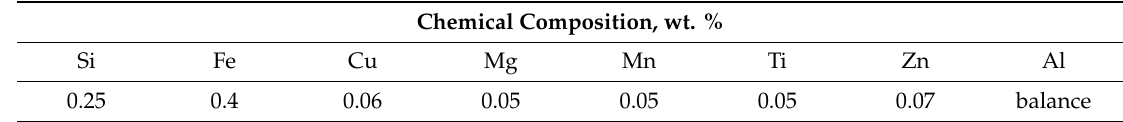
Table 5. Composition of AA1050